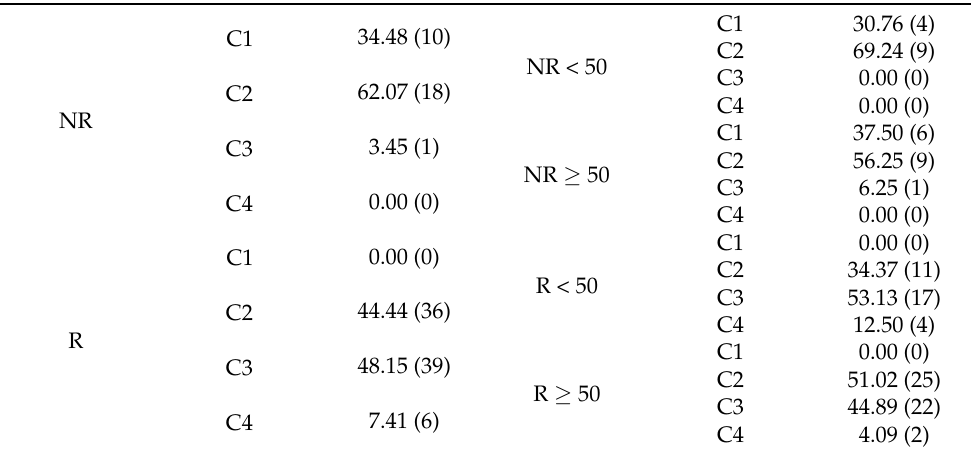
Table 1. Patients according to CEAP